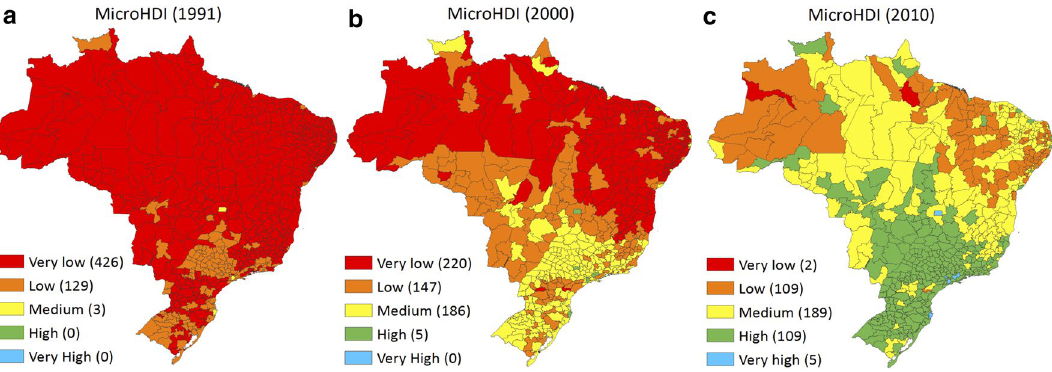
Fig. 1 Brazilian Microregional Human Development Index (MicroHDI) from five human development ranges. MicroHDI values from Eq. 1, 1991 ( a ), 2000 ( b ) and 2010 ( c